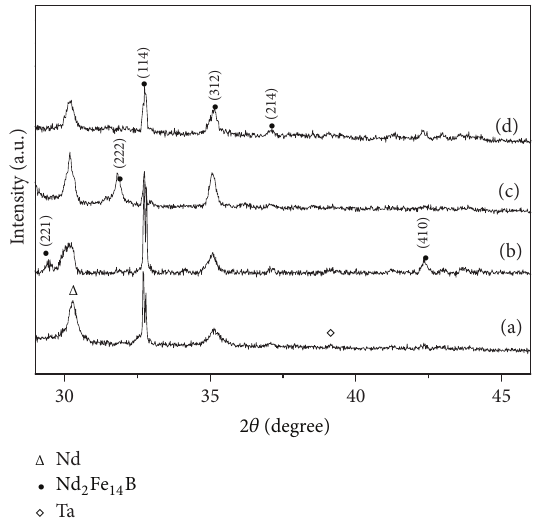
Figure 1: XRD patterns of Ta/Nd/NdFeB ( 𝑥 nm)/Nd/Ta ((a) 𝑥 = 450 ; (b) 𝑥 = 600 ; (c) 𝑥 = 750 ; (d) 𝑥 = 900 ) films.